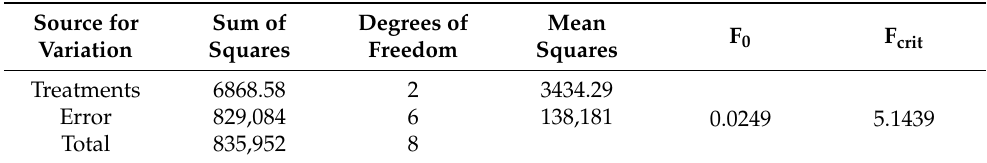
Table 5. The ANOVA results for the elastic modulus. Source for Sum of Variation Squares